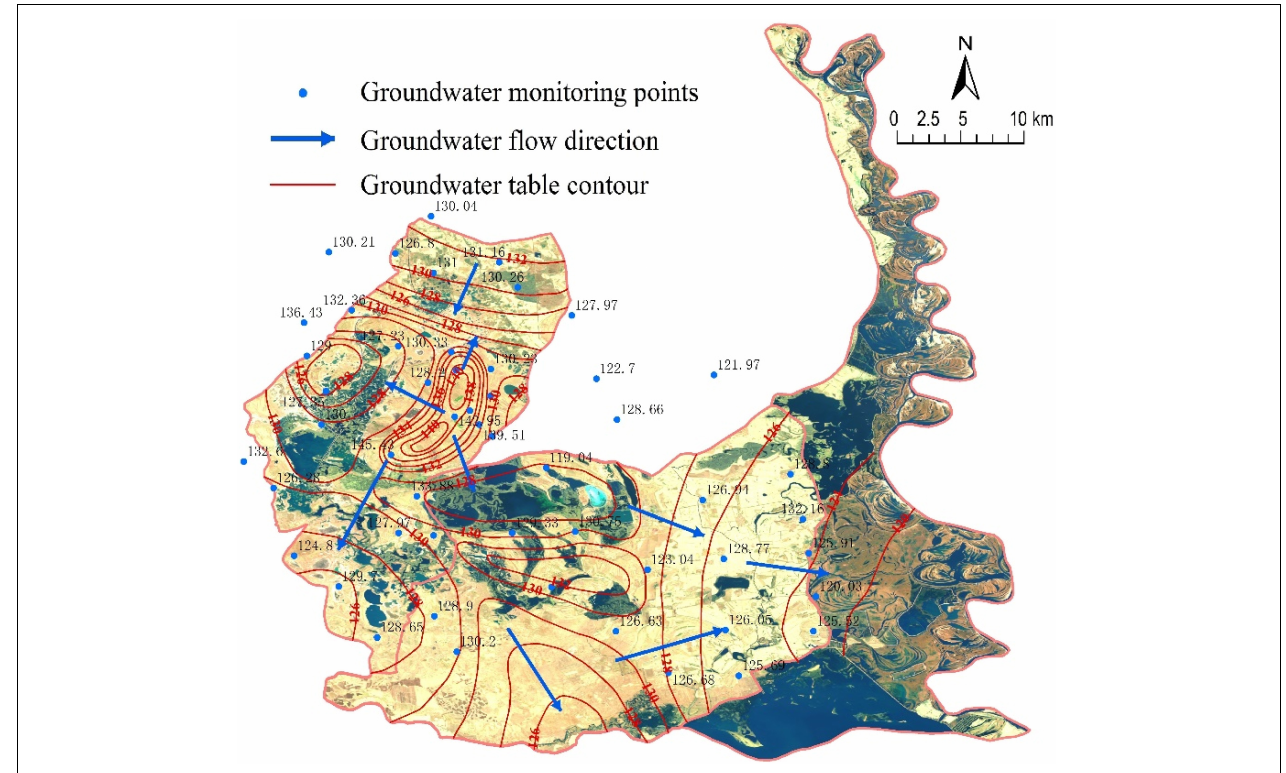
FIGURE 9 | Groundwater table contour in November 2019 (a.m.s.l).